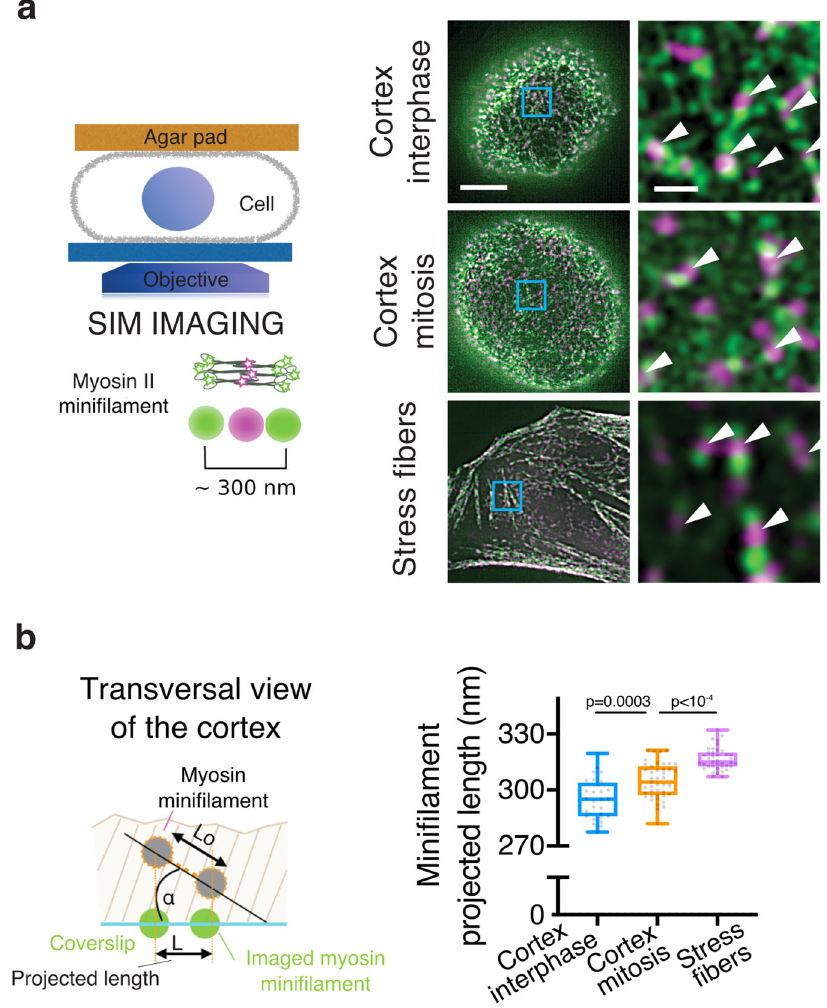
Fig. 1 Changes in myosin mini fi lament orientation between interphase and mitosis. a Left: schematic representation of the SIM imaging setup. Cells are compressed under an agar pad, so that a large fl at cortical surface can be imaged. Right: representative SIM images of the bottom surface of rounded interphase, mitotic, and spread interphase cells expressing EGFP – NMM HC IIB and NMM HC IIB-tdTom. Arrowheads highlight myosin mini fi laments. Scale bars, 5 µ m and 0.5 µ m. b Left: schematic of the mini fi lament projected length measurement (see Supplementary Fig. 2 for method). Right: projected lengths of myosin mini fi laments in the cortex of rounded interphase and mitotic cells, and in stress fi bers in spread interphase cells; n = 28, 43, and 51 cells, and 2, 3, and 2 independent experiments, respectively; 100 – 500 mini fi laments measured per cell. Boxplots show 25th – 75th percentiles, the median, and whiskers from minimum to maximum. Statistics: Welch ’ s t- test (two-tailed). Source data are provided as a Source Data